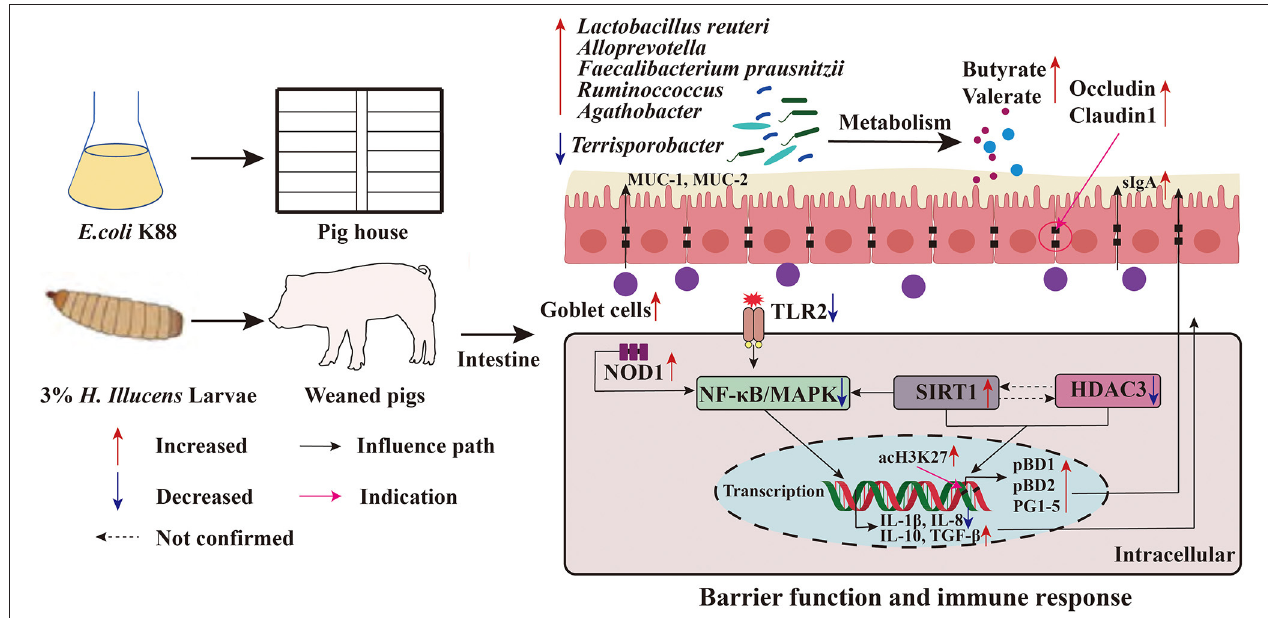
FIGURE 8 | Function model of the proposed Hermetia illucens larvae meal. The red arrow indicates an increase in the value of the detected parameter compared to NC or PC, and blue indicates a